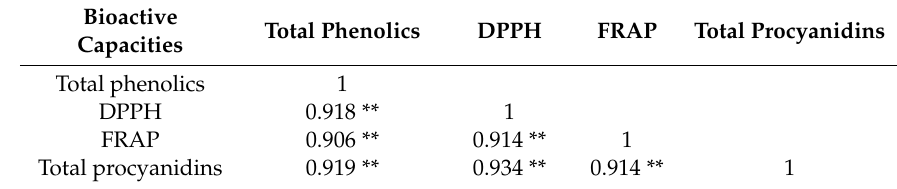
Table 3. Correlation analysis (R 2 ) among total phenolics content, total procyanidins content and antioxidant activities (by DPPH and FRAP assays).